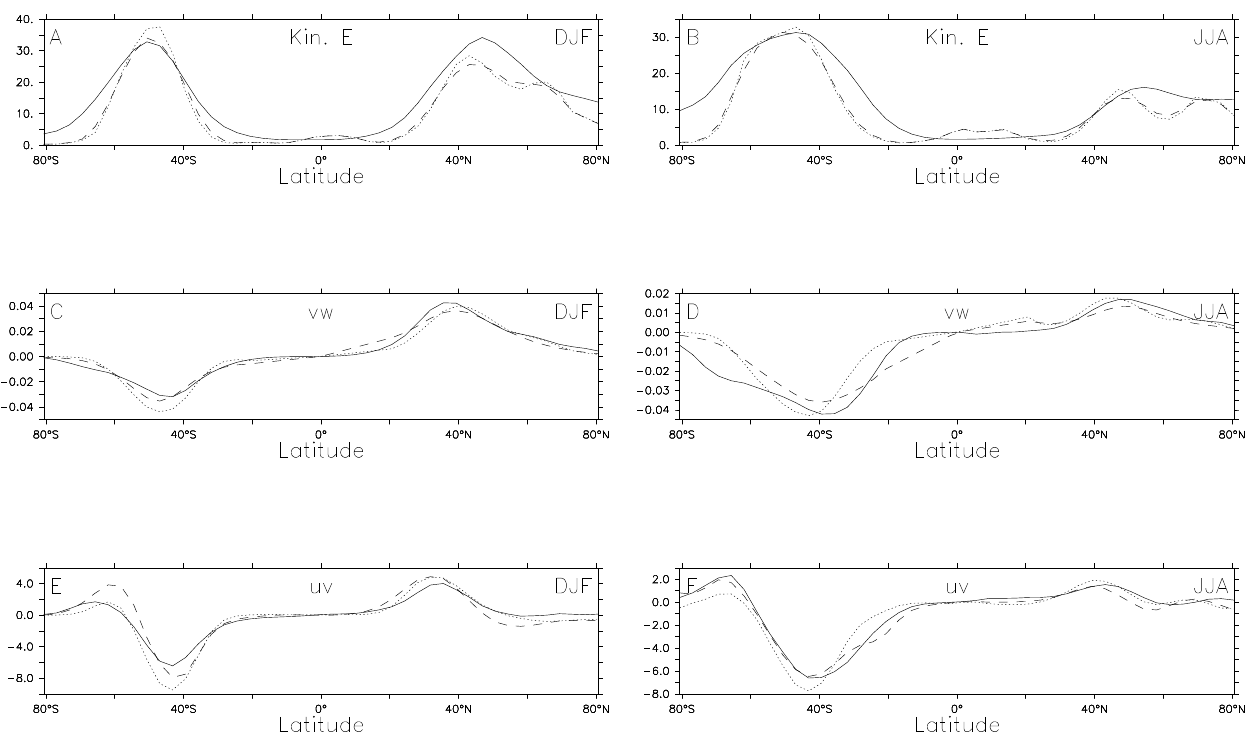
i (a, b) , h v 0 w 0 i (c, d) and h u 0 v 0 i (e, f) , all in m 2 s − 2 , for December-January- k